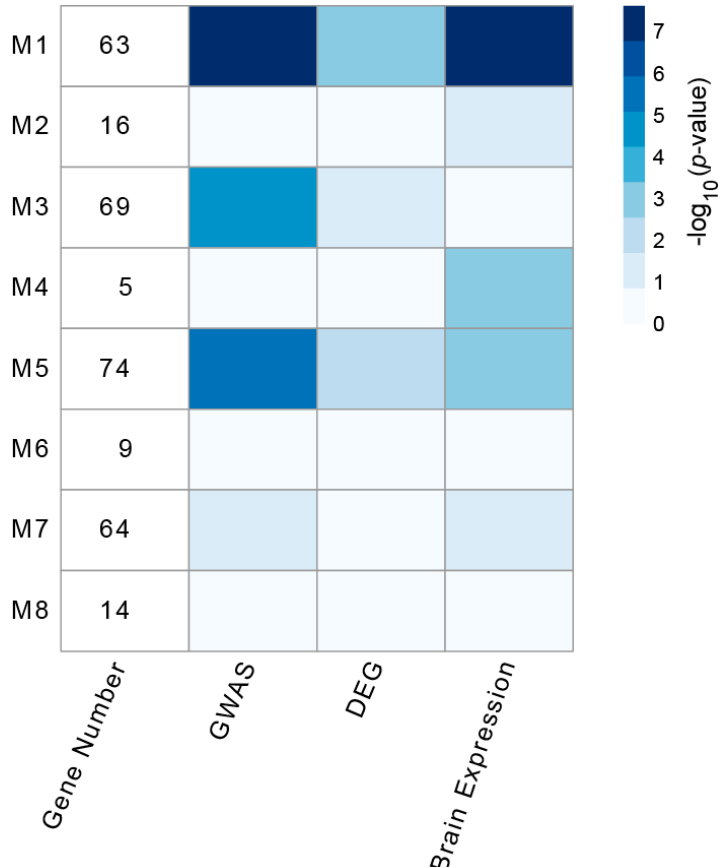
Figure 2. Densely connected modules in the delirium PPI network. Eight significantly connected PPI modules were extracted from the delirium PPI network, using the Molecular Complex Detection (MCODE) plugin. Module-level enrichment was assessed for three delirium-related gene sets: delirium-associated genes derived from genome-wide association studies (GWASs), differentially expressed genes for the mouse delirium model (DEG), and the brain-expressed gene set (Brain Expression). The blue colors in each cell indicate the p -value for significance of overlap, using Fisher’s exact test ( − log 10 ( p -value)).